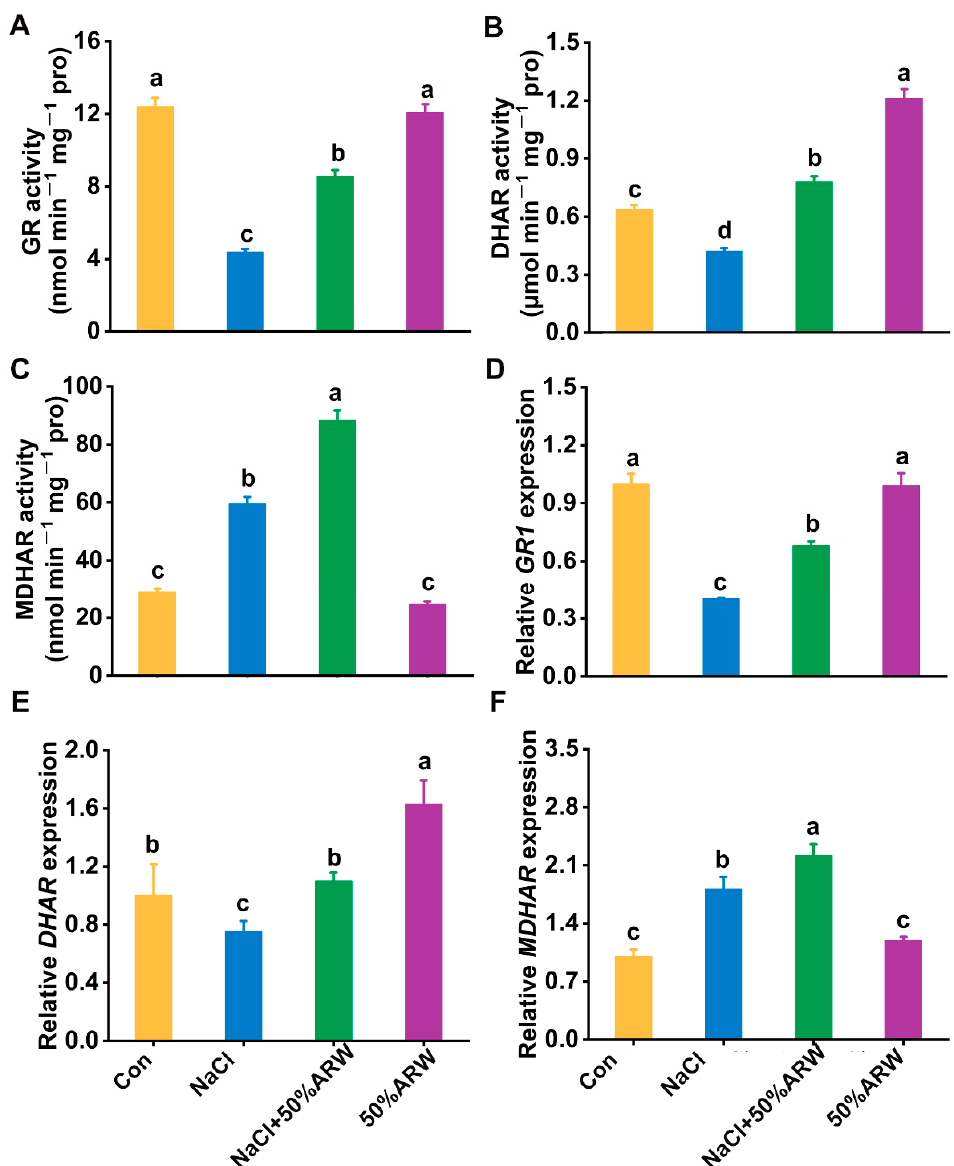
Figure 6. Changes in AsA-GSH-related antioxidant enzyme activities and transcripts in alfalfa plants. After germination for 3 d, the activities of GR ( A ), DHAR ( B ), and MDHAR ( C ) were determined. Transcripts of GR1 ( D ), DHAR ( E ), and MDHAR ( F ) were analyzed by qPCR. See Table S1 for detailed gene expression information. The error bars represent the SD ( n = 3). Bars with different letters were significantly different at p < 0.05 according to Duncan’s multiple range test.